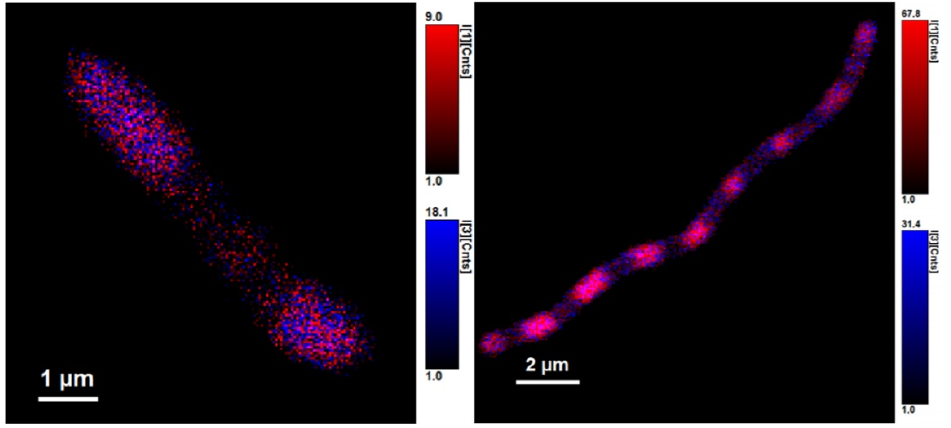
Figure 10. Cupriavidus necator PHB-4.